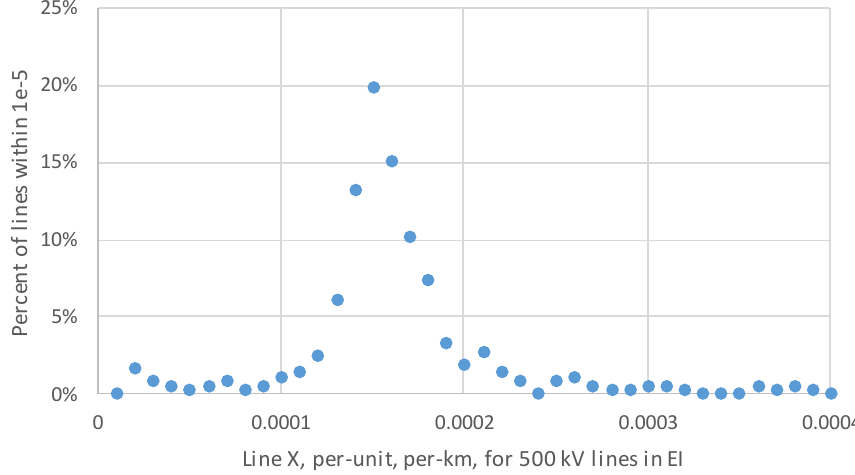
Line X, per-unit, per-km, for 500 kV lines in EI Figure 7. Discrete probability transmission line impedance characteristics, for 500 kV lines in the EI.